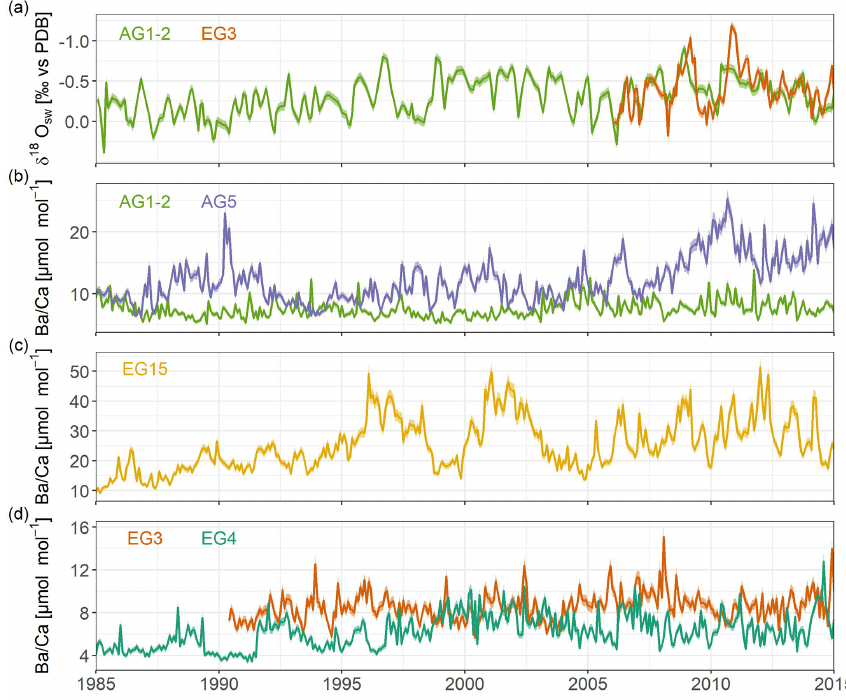
Figure 2. Monthly interpolated time series of (a) reconstructed δ 18 O sw for Anemone’s Garden 1 (AG1–2) in light green and Eve’s Garden 3 (EG3) in orange (Krawczyk et al., 2020) and Ba / Ca ratios of (b) Anemone’s Garden 1 and 5 (AG1–2 and AG5) in light green and blue, (c) Eve’s Garden 15 (EG15) in yellow, and (d) Eve’s Garden 3 and 4 (EG3 and EG4) in orange and dark green, respectively, with shading indicating analytical error. Note that the y axis on the (a) panel is